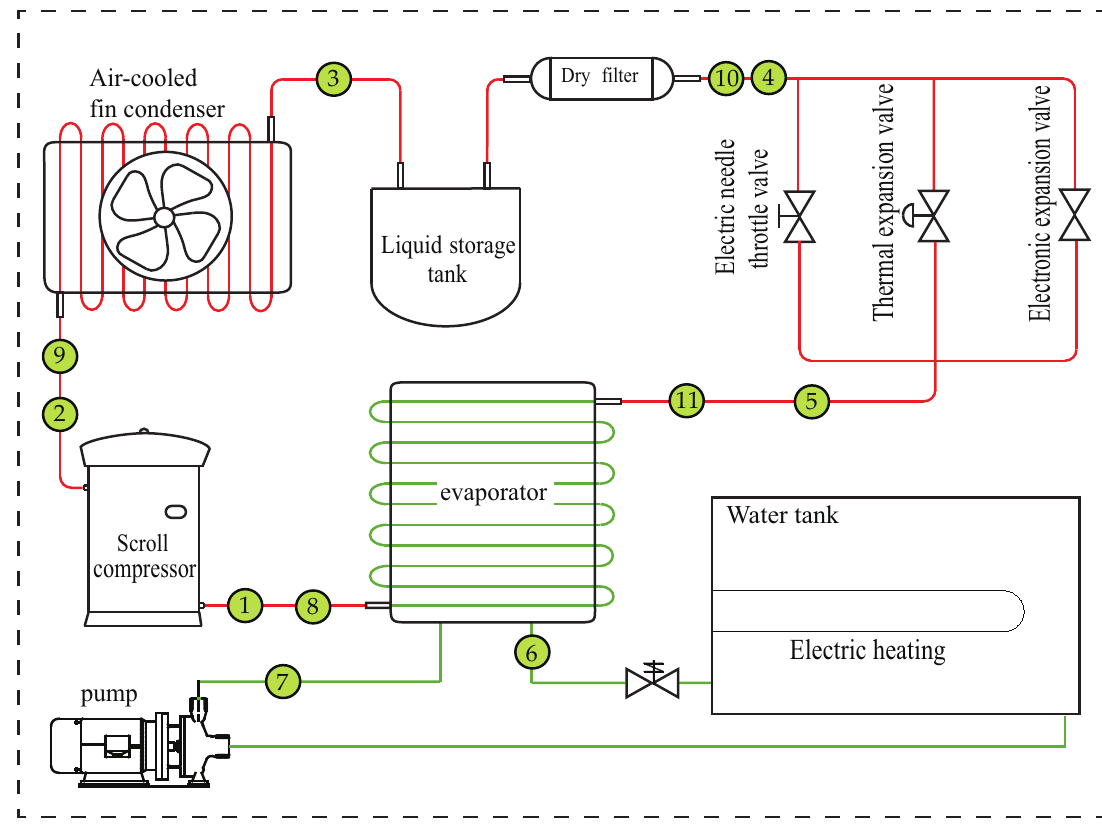
Figure 1. Schematic diagram of the air-cooled chiller system. The system consists of refrigerant closed loop and chilled water closed